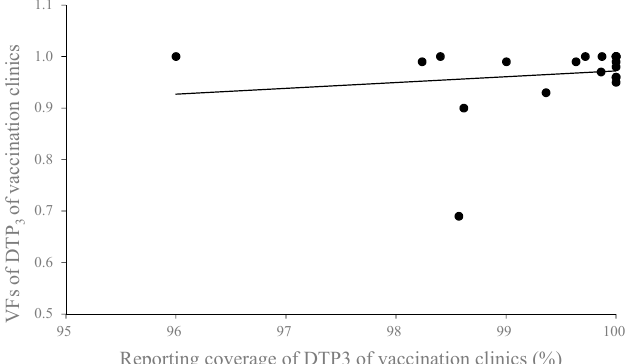
Figure 3. Correlation between the VF of DTP 3 (diphtheria–tetanus–pertussis combined vaccine) and the reporting coverage of DTP 3 at the vaccination clinic level from the data quality audit (DQA) in Shangyu District, 2014.